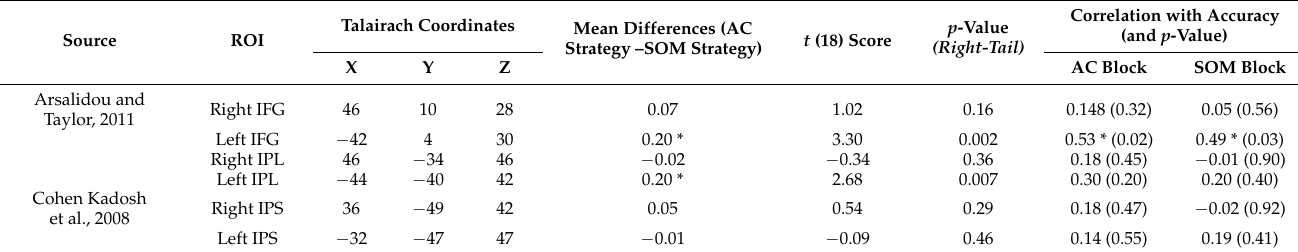
Table 4. Region of interest analysis.